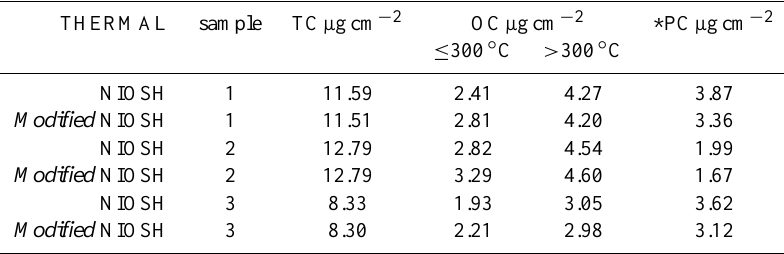
Table 2. TC OC and PC, in µgCcm − 2 units, obtained from analysis of aerosol samples using both a EPA/NIOSH thermal protocol (Peterson and Richards, 2002) and a version modified by the addition of steps at low temperature. OC is reported as the organic carbon peaks, evolved in the He-mode prior to and after 300 ◦ C; PC is estimated by the sample transmittance over the entire He-mode and assuming a specific attenuation cross section of 45m 2